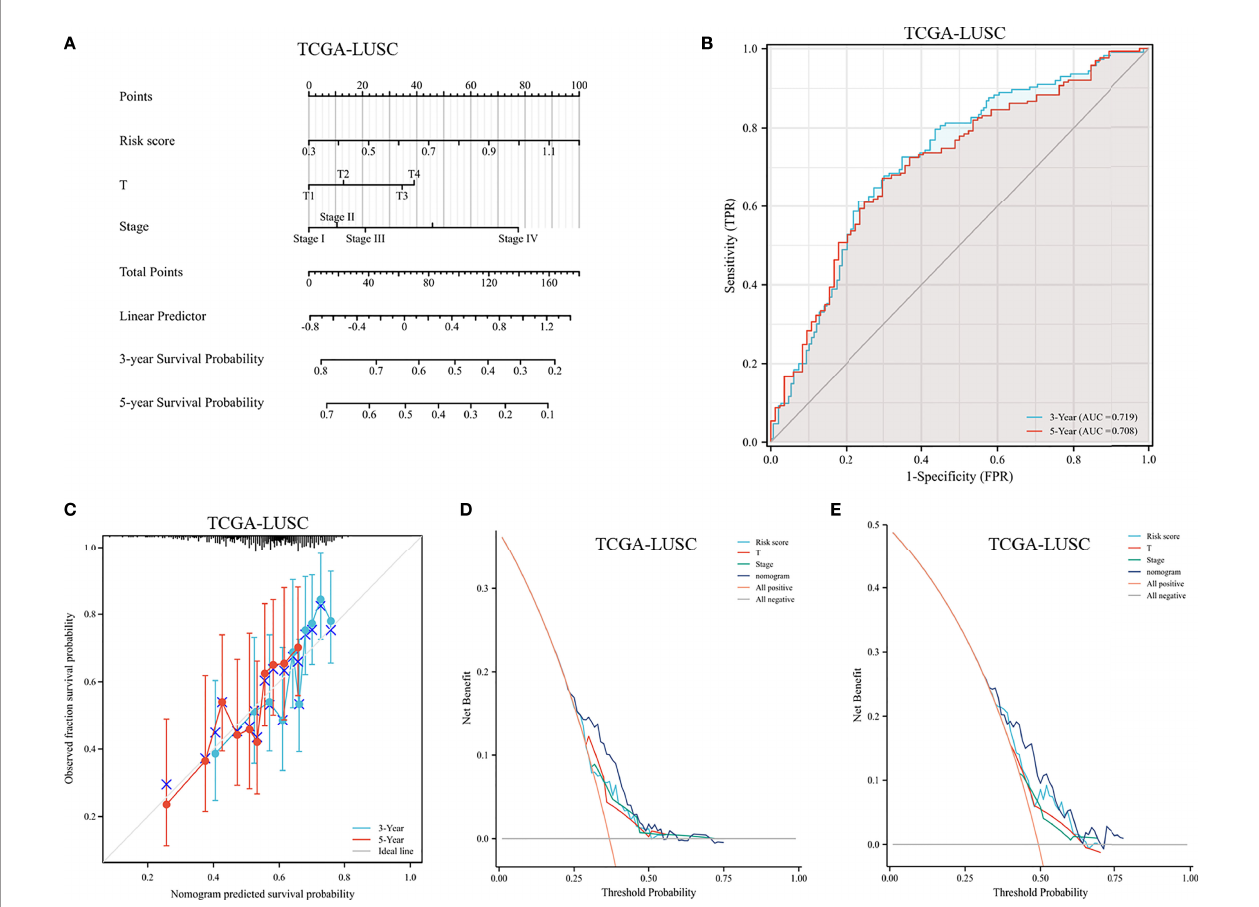
FIGURE 12 | Assessment of a nomogram based on clinical characteristics and the risk scores. (A) A nomogram based on the risk model and clinical parameters. (B) Time-dependent receiver operating curve for predicting overall survival. (C) Calibration curve of the nomogram in the TCGA dataset at 3-year survival and 5-year survival. (D, E) DCA evaluating the clinical usefulness in the TCGA dataset at 3-year survival (D) and 5-year survival (E)